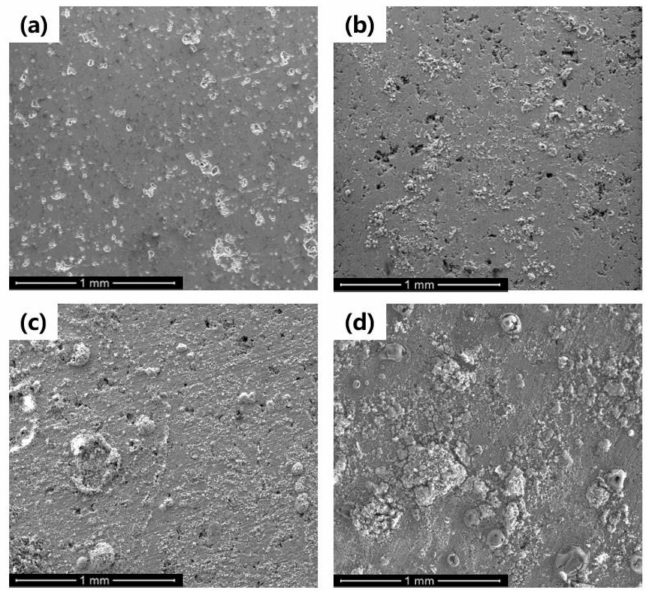
Figure 11. Corrosion morphologies of Al–BN ACS after immersion time in 5.0 wt % NaCl solution for ( a ) 0, ( b ) 8, ( c ) 24, and ( d ) 72 h.